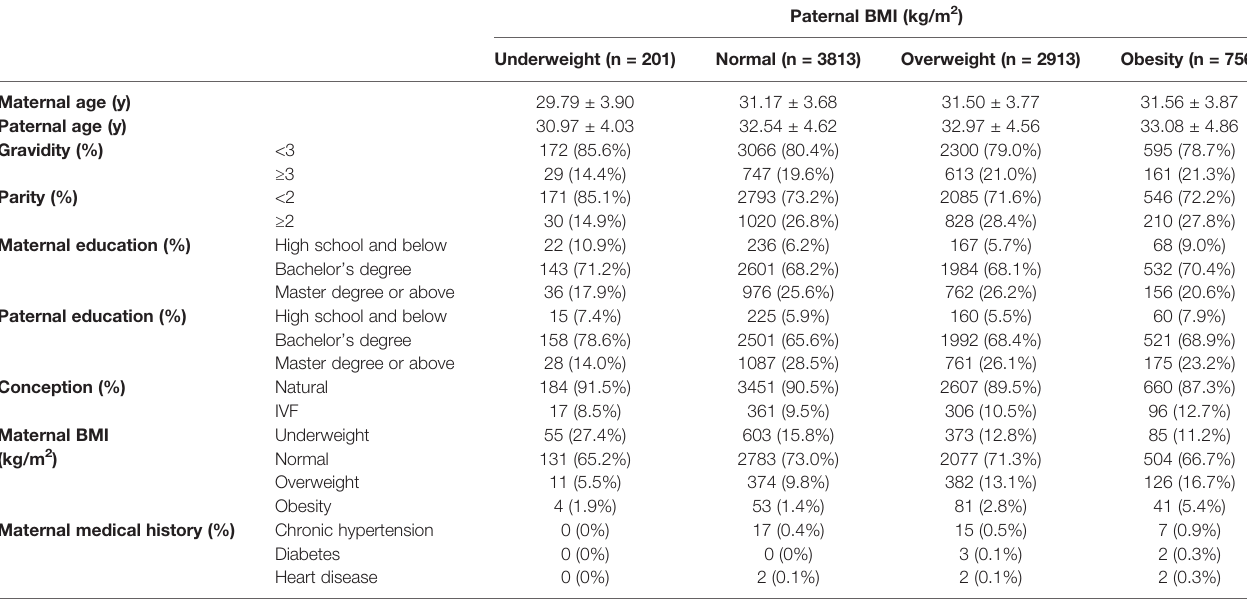
TABLE 1 | Baseline characteristics of patients in the